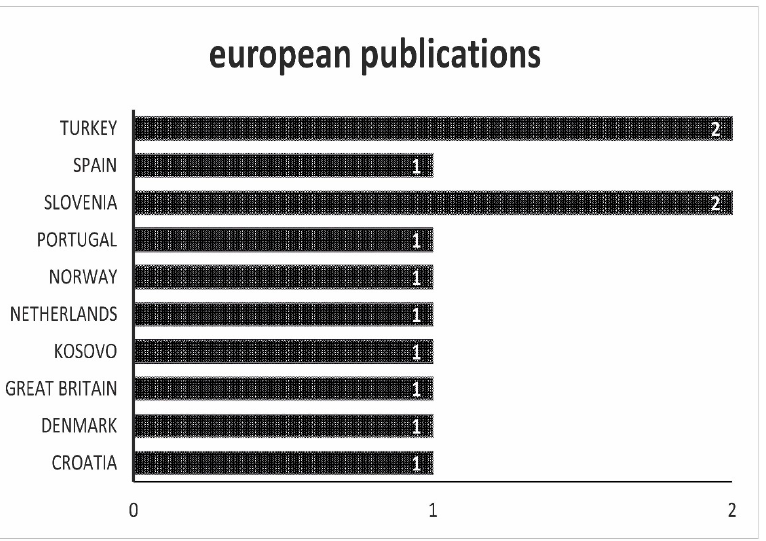
Figure 4. Overview of the origin of the scientific work. In this figure, all works that come from Europe are listed.